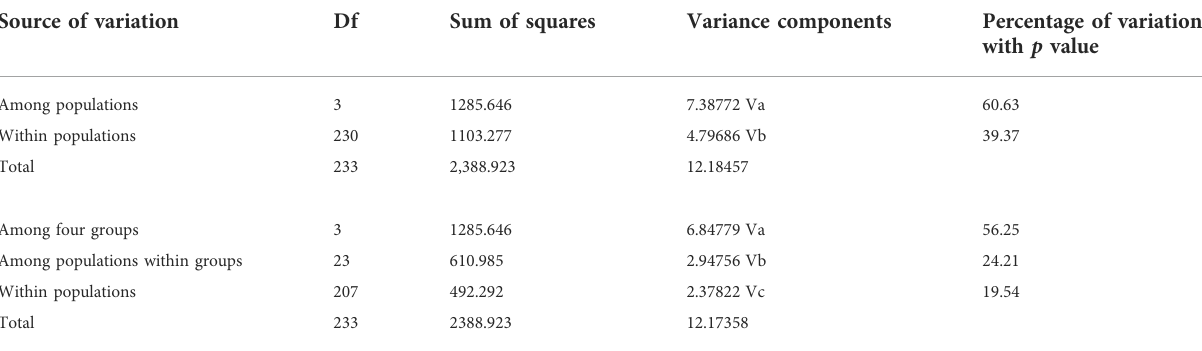
TABLE 2 Analysis of molecular variance partitioning the genetic variance within and among populations, and molecular variance results comparing genetic variation among four groups (HS1-4 and TH1-4 as Yellow River system in Northeastern QTP; JLJ1-6 as Yangtze River system in NortheasternQTP;LBW,LSH,LSM,LNS,YYJ,YYS,XA,LCB,LCC,andSXYasYellowRiversysteminQinlingMountains;otherfourpopulationsasRiver systems in Southern Taihang Mountains). Source of variation Df Sum of squares Variance